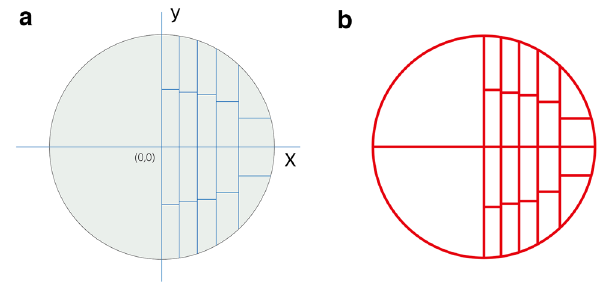
Figure 6. ( a , b ) Vectorized the comparison card.